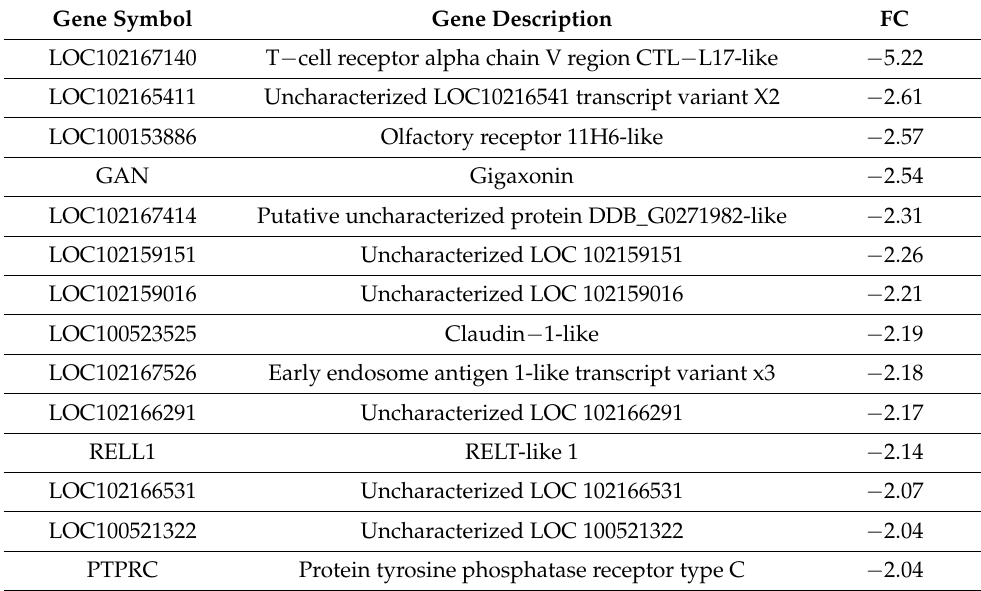
Table 5. Gene symbol, gene description, and logarithm of fold change (FC) of differentially expressed (downregulated) genes between cd26-siRNA-injected and non-injected porcine